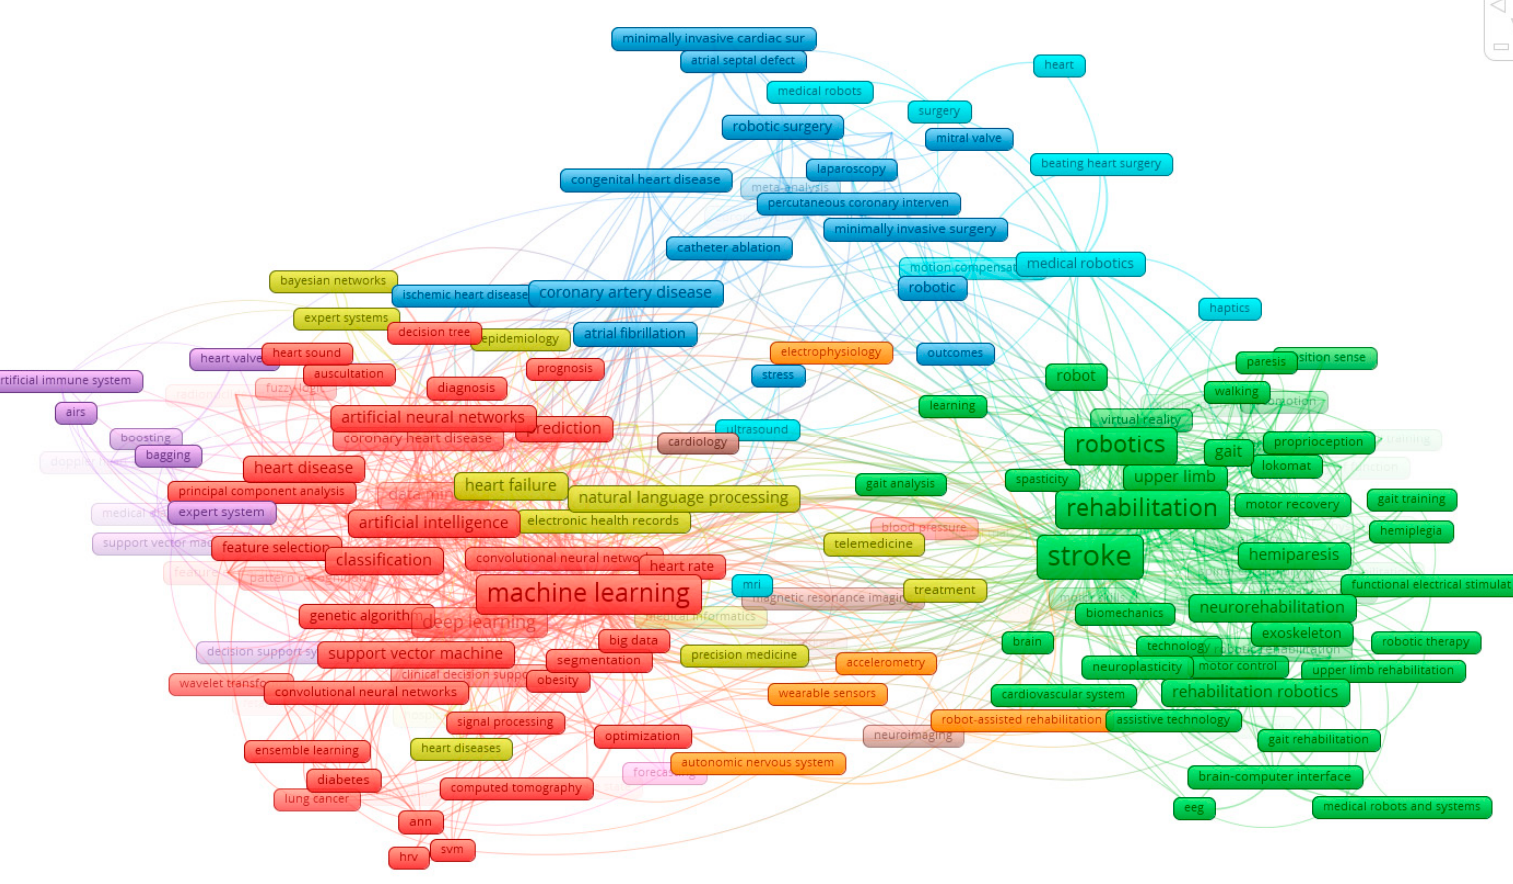
Figure 2. Co-occurrence of the most frequent author’s keywords. Note: the colors of the nodes indicate principle components of the data structure; node size was scaled to keyword occurrences; the thickness of the lines was drawn based on the strength of the association between two keywords. (ANN: artificial neural network; EEG: electroencephalogram; HRV: heart rate variability; MRI: magnetic resonance imaging; SVM: support vector machine)